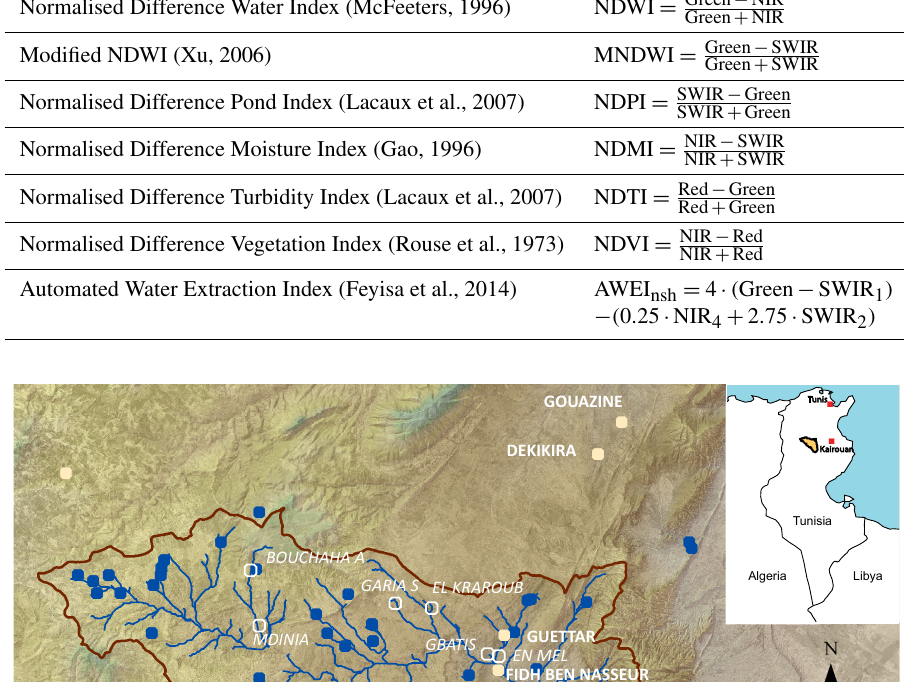
Table 1. Spectral water indices compared in this paper. Normalised Difference Water Index (McFeeters, 1996) NDWI = Green − NIR Modified NDWI (Xu, 2006) MNDWI = Green − SWIR Normalised Difference Pond Index (Lacaux et al., 2007) NDPI = SWIR − Green Normalised Difference Moisture Index (Gao, 1996) NDMI = NIR − SWIR Normalised Difference Turbidity Index (Lacaux et al., 2007) NDTI = Red − Green Normalised Difference Vegetation Index (Rouse et al., 1973) NDVI = NIR − Red Automated Water Extraction Index (Feyisa et al., 2014)